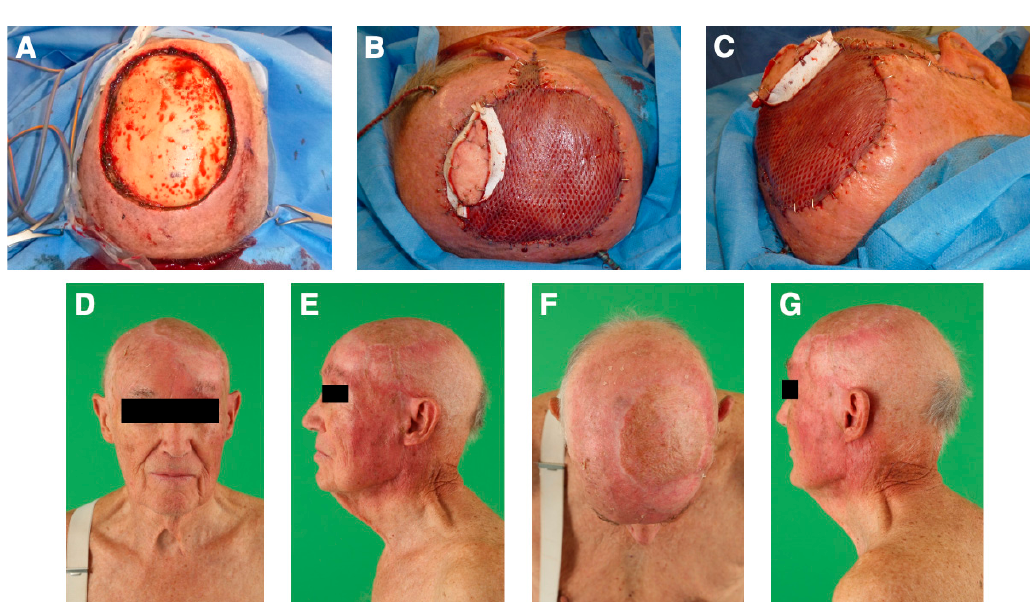
Figure 4. An 87-year-old male patient was diagnosed with a high-grade cutaneous